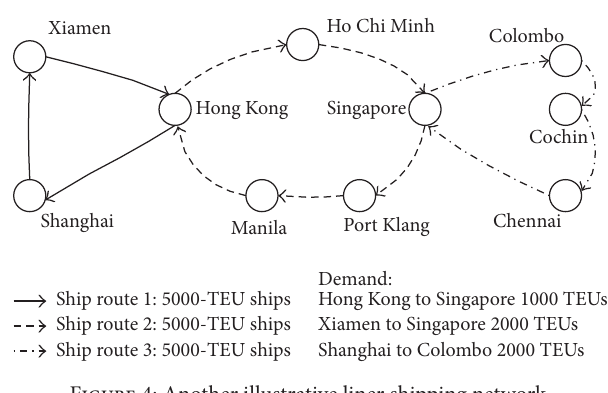
Figure 4: Another illustrative liner shipping